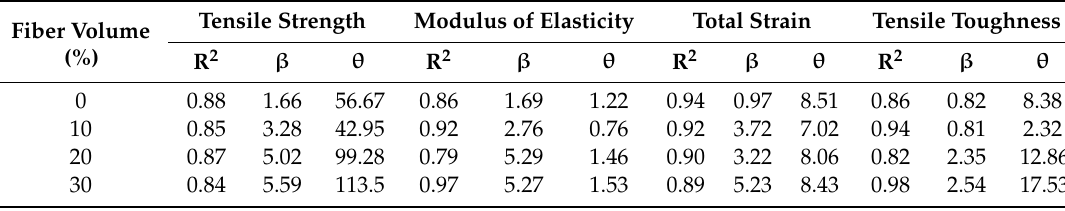
Table 3. Weibull parameters for the measured properties by the tensile strength test of epoxy composites reinforced with caranan fiber Weibull analysis.